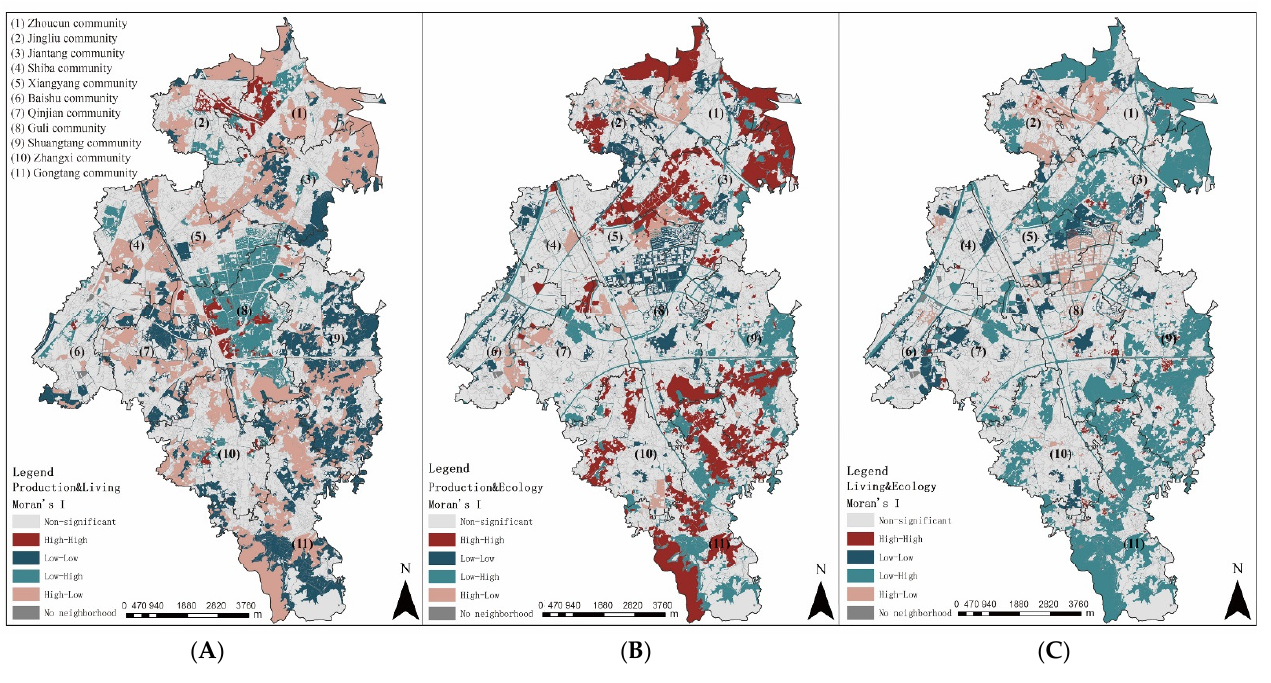
Figure 7. Function autocorrelations of PLE spaces. ( A ) Production & Living functions; ( B ) Production & Ecological functions; ( C ) Living & Ecological functions. Table 5. Proportion of the autocorrelation indexes of PLE functions at village-level administrative areas; unit: percentage.